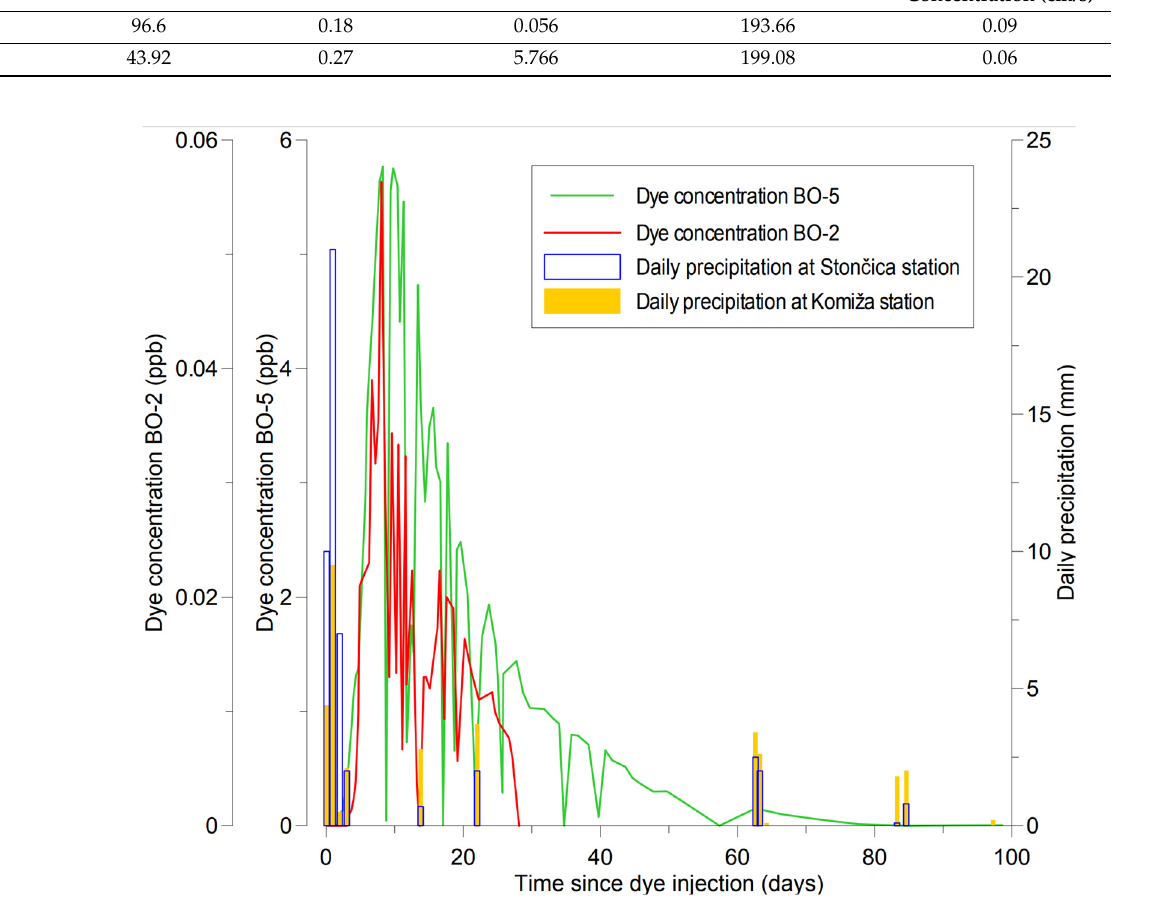
Figure 7. Dye curve for wells BO-2 and BO-5 in Korita and daily precipitation during the test.